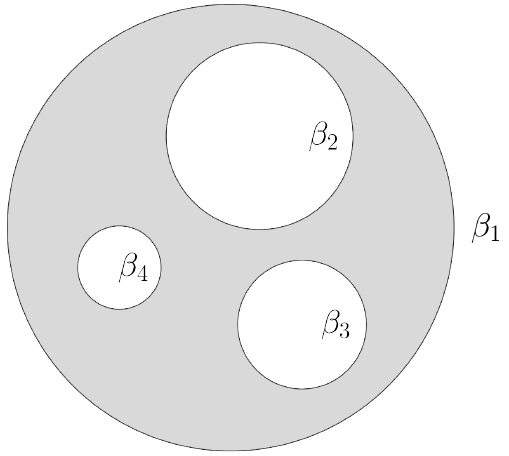
Figure 9 . Example of a flat surface that would contribute to h Z ( β 1 ) Z ( β 2 )( Z ( β 3 ) Z ( β 4 ) i c in the \ finite cutoff version of CGHS. It would be interesting to define and study this